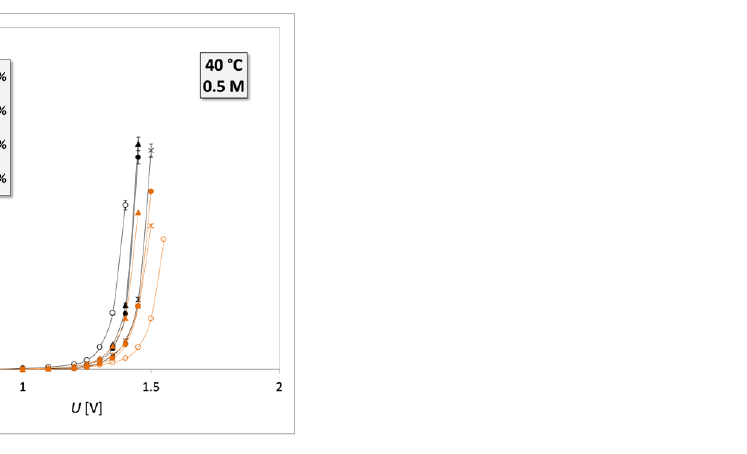
Figure 3. Electro-oxidation curves of Syntanol DS-10 detergent (orange lines) and waste engine oil emulsion (black lines) at the temperature of 40 ◦ C in a 0.5 M aqueous solution of H 2 SO 4 , for various concentrations of detergent and emulsion (0.005%, 0.010%, 0.030%, and 0.060% of reactor volume).